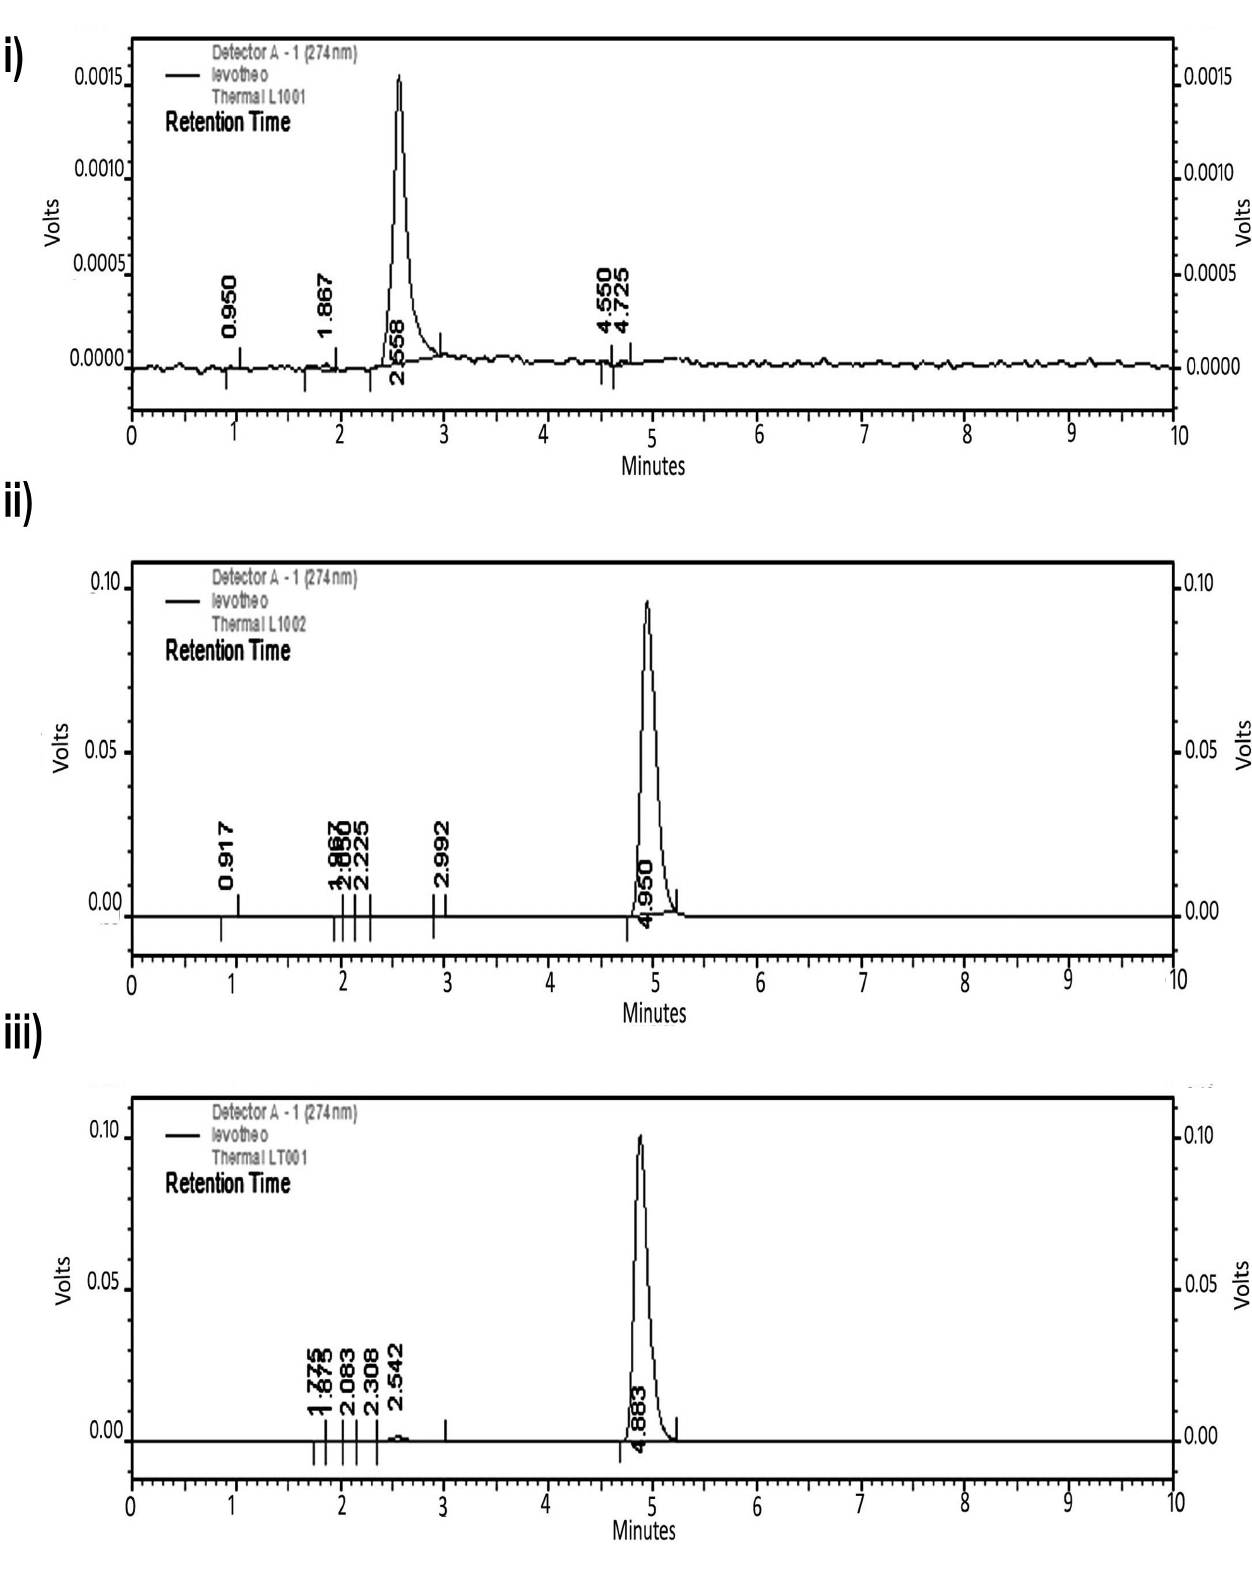
FIGURE 3E - Representative chromatograms of thermally degraded drugs. Each chromatogram represents (i) levosalbutamol sulfate (1 μg. mL -1 ), (ii) theophylline (10 μg. mL -1 ), (iii) dosage form having levosalbutamol sulfate (1 μg. mL -1 ) and theophylline (10 μg. mL -1